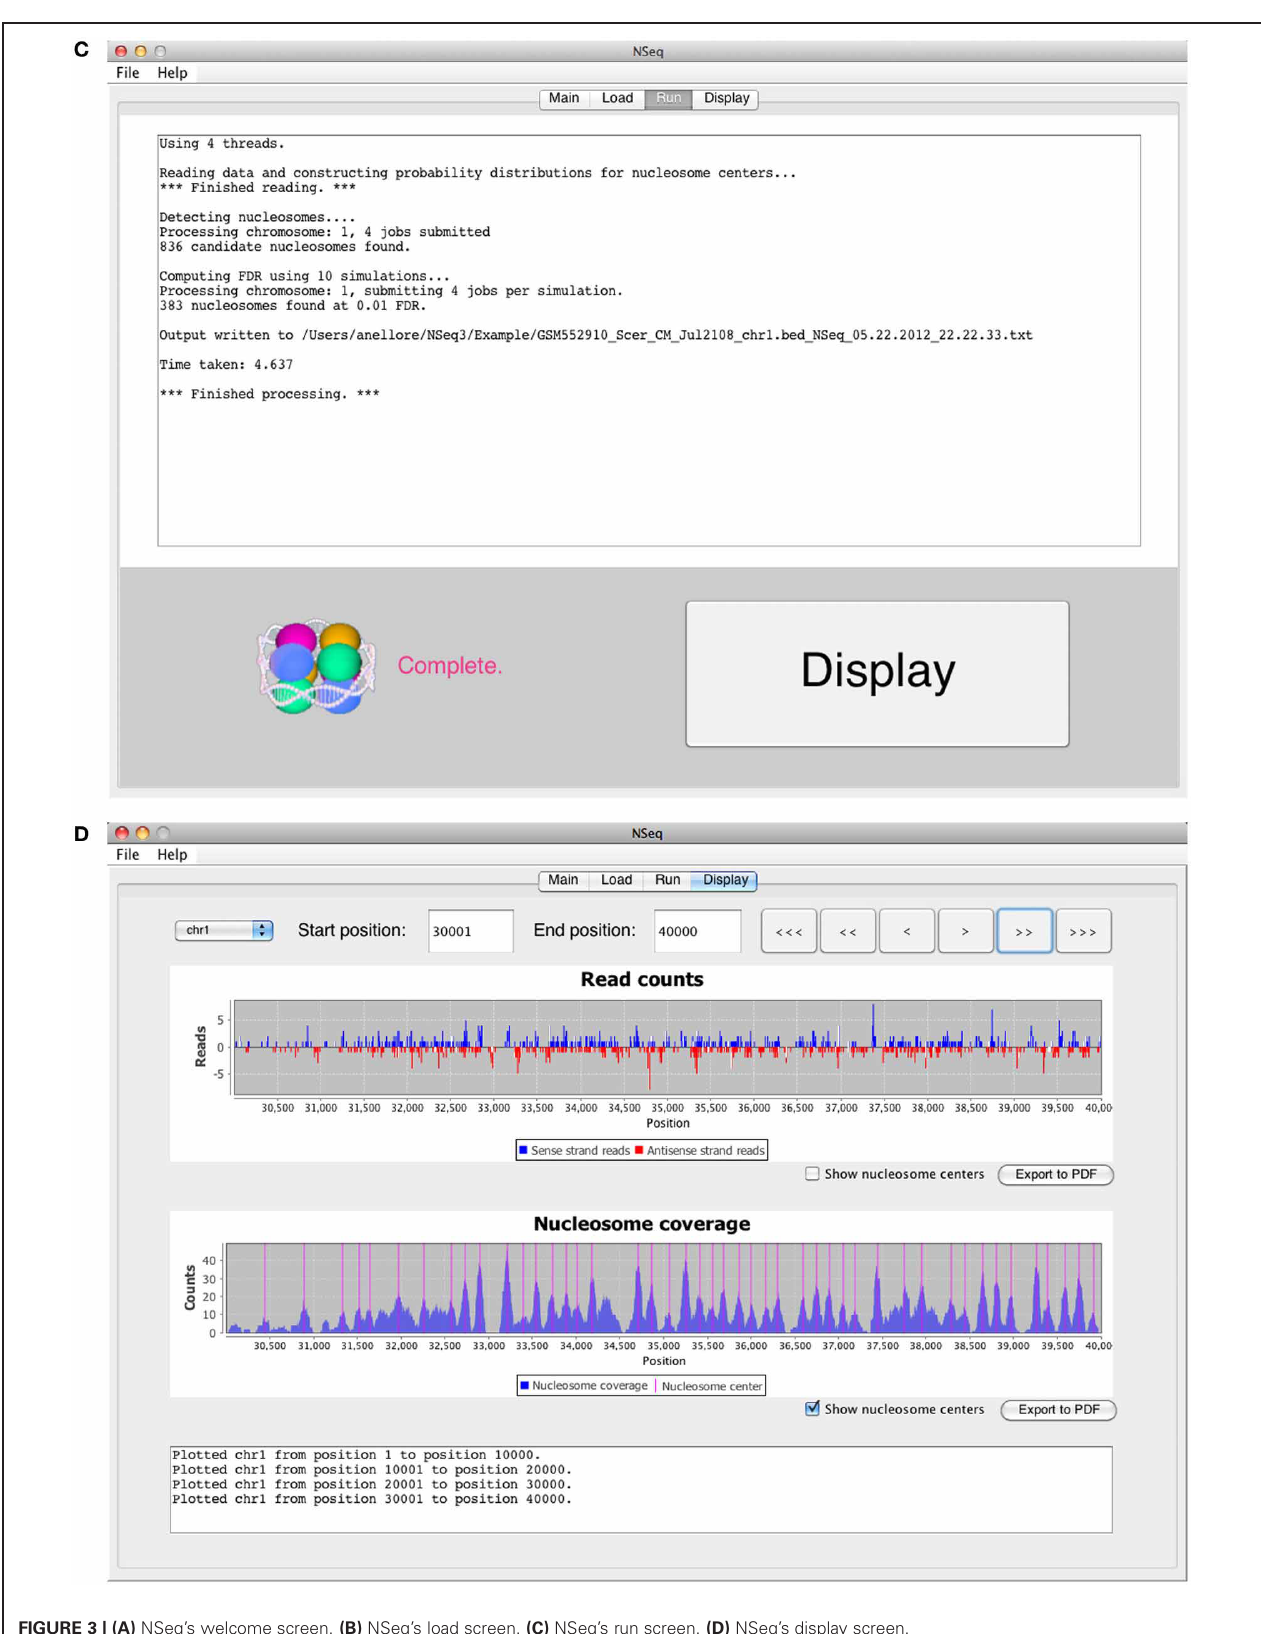
FIGURE 3 | (A) NSeq’s welcome screen. (B) NSeq’s load screen. (C) NSeq’s run screen. (D) NSeq’s display screen.